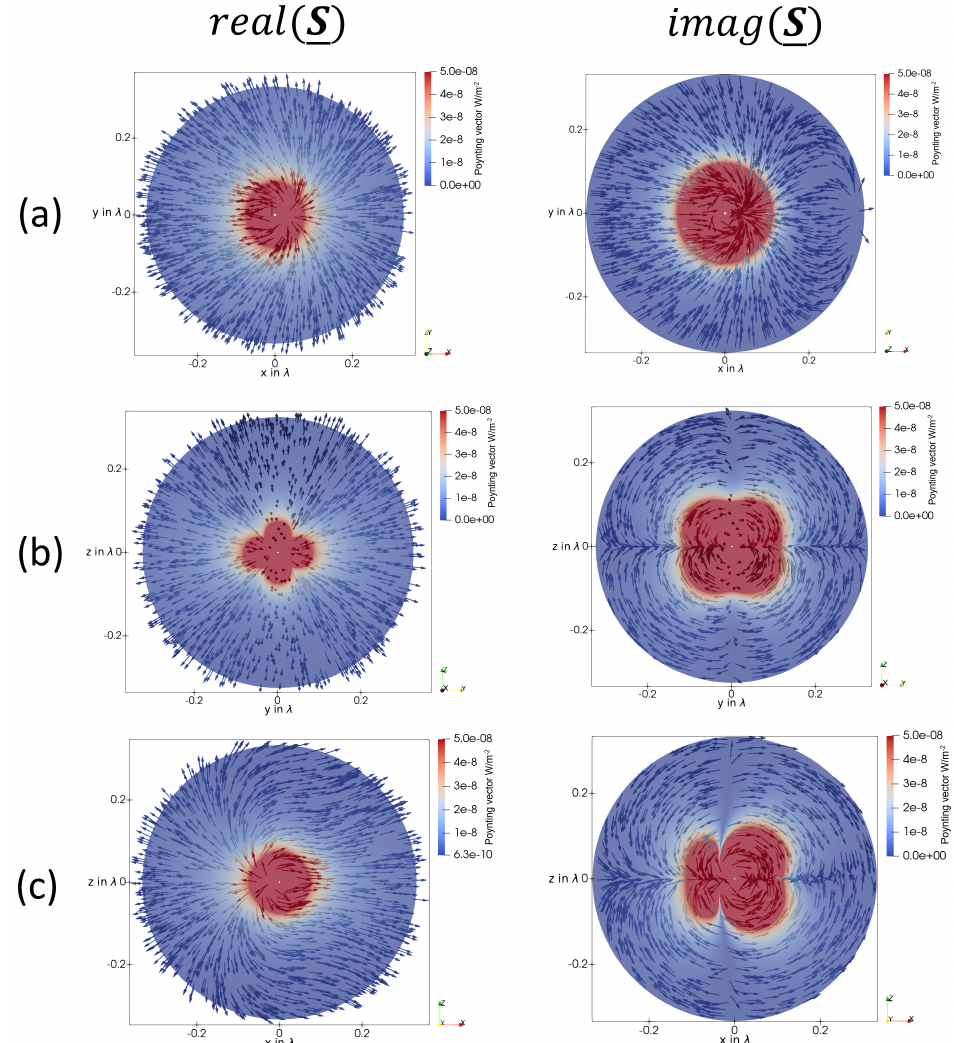
Figure 17. ( a ) The real and imaginary part of the Poynting vector in the xy-plane of a loop antenna with an overall circumference of C = 0.01 λ . ( b ) The real and imaginary part of the Poynting vector in the yz-plane of a loop antenna with an overall circumference of C = 0.01 λ . ( c ) The real and imaginary part of the Poynting vector in the zx-plane of a loop antenna with an overall circumference of C = 0.01 λ